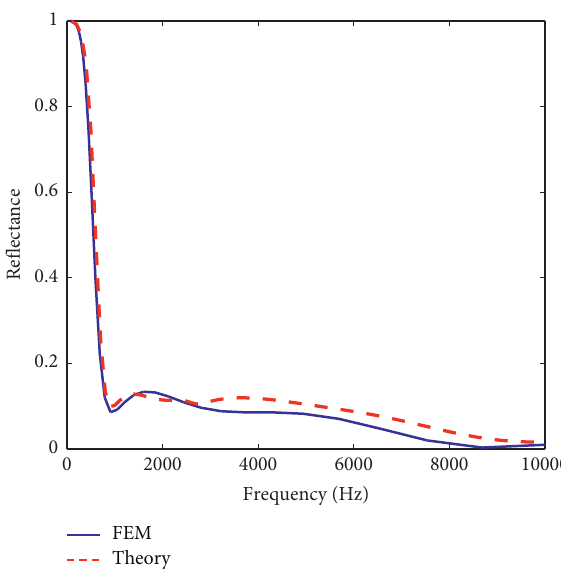
Figure 4: Comparison of theoretical calculations and finite element simulation